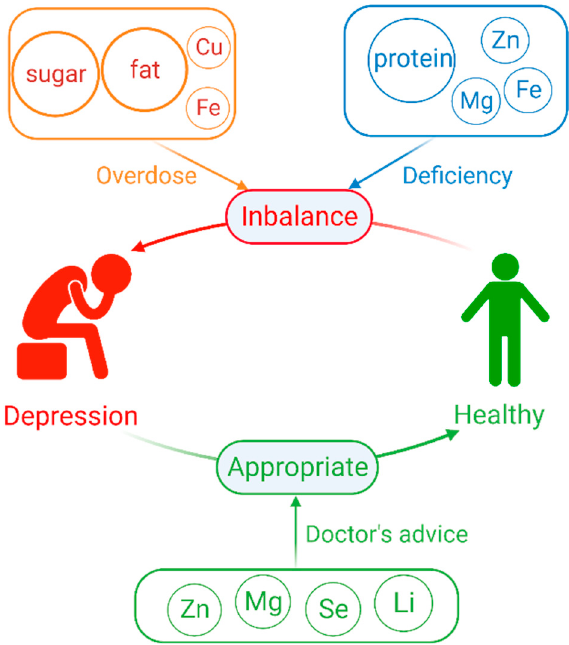
Figure 2. Summarize the relationship between depression and elements. Cu (copper), Fe (iron), Zn (zinc), Mg (magnesium), Se (selenium), Li (lithium) .